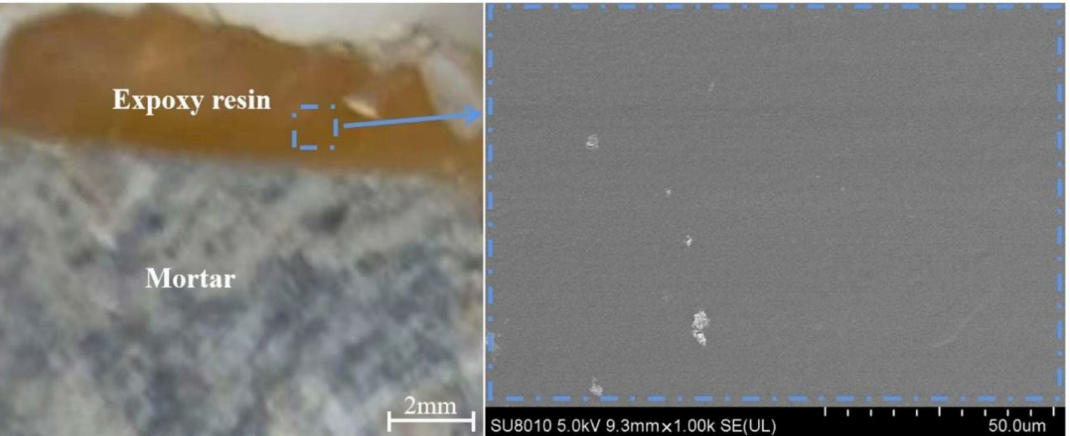
Figure 13. Microstructure of epoxy resin